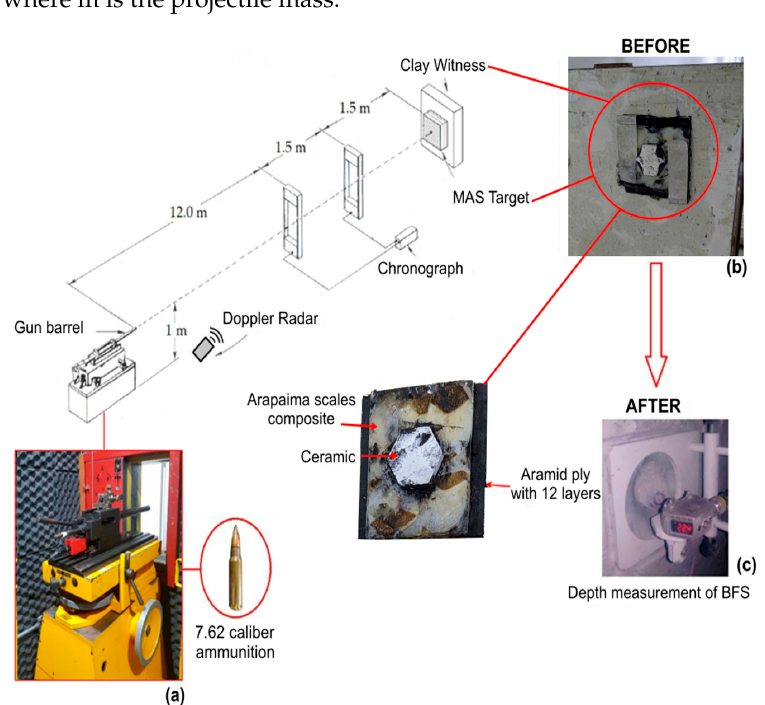
Figure 3. Schematic diagram of the CAEX shooting line showing, in accordance with the NIJ standard procedure [36]: ( a ) the gun barrel and the 7.62 caliber ammunition used; ( b ) the arapaima scales-epoxy intermediate layer MAS mounted on the clay witness; and ( c ) the measurement procedure using a laser sensor.